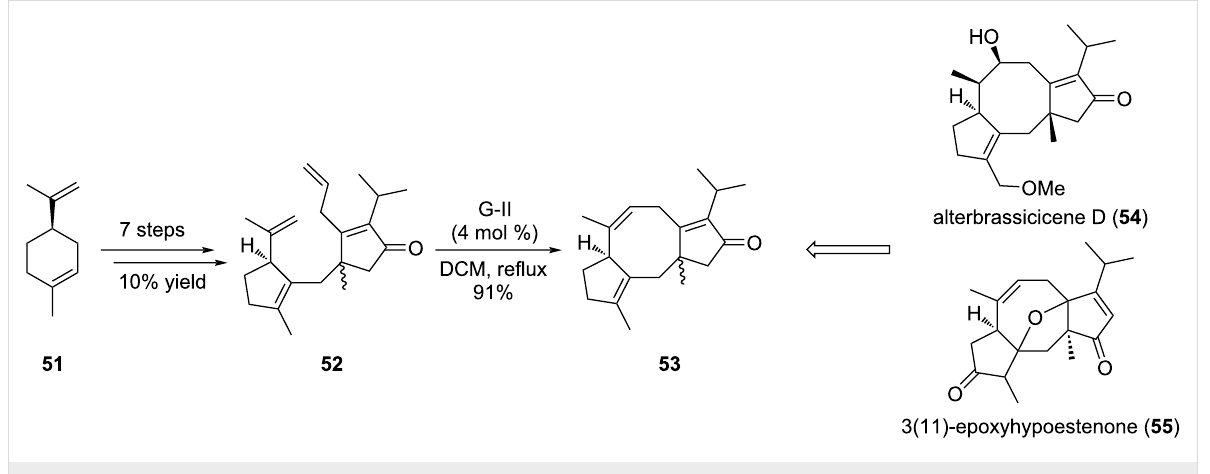
Scheme 8: Synthesis of tricyclic core structure of